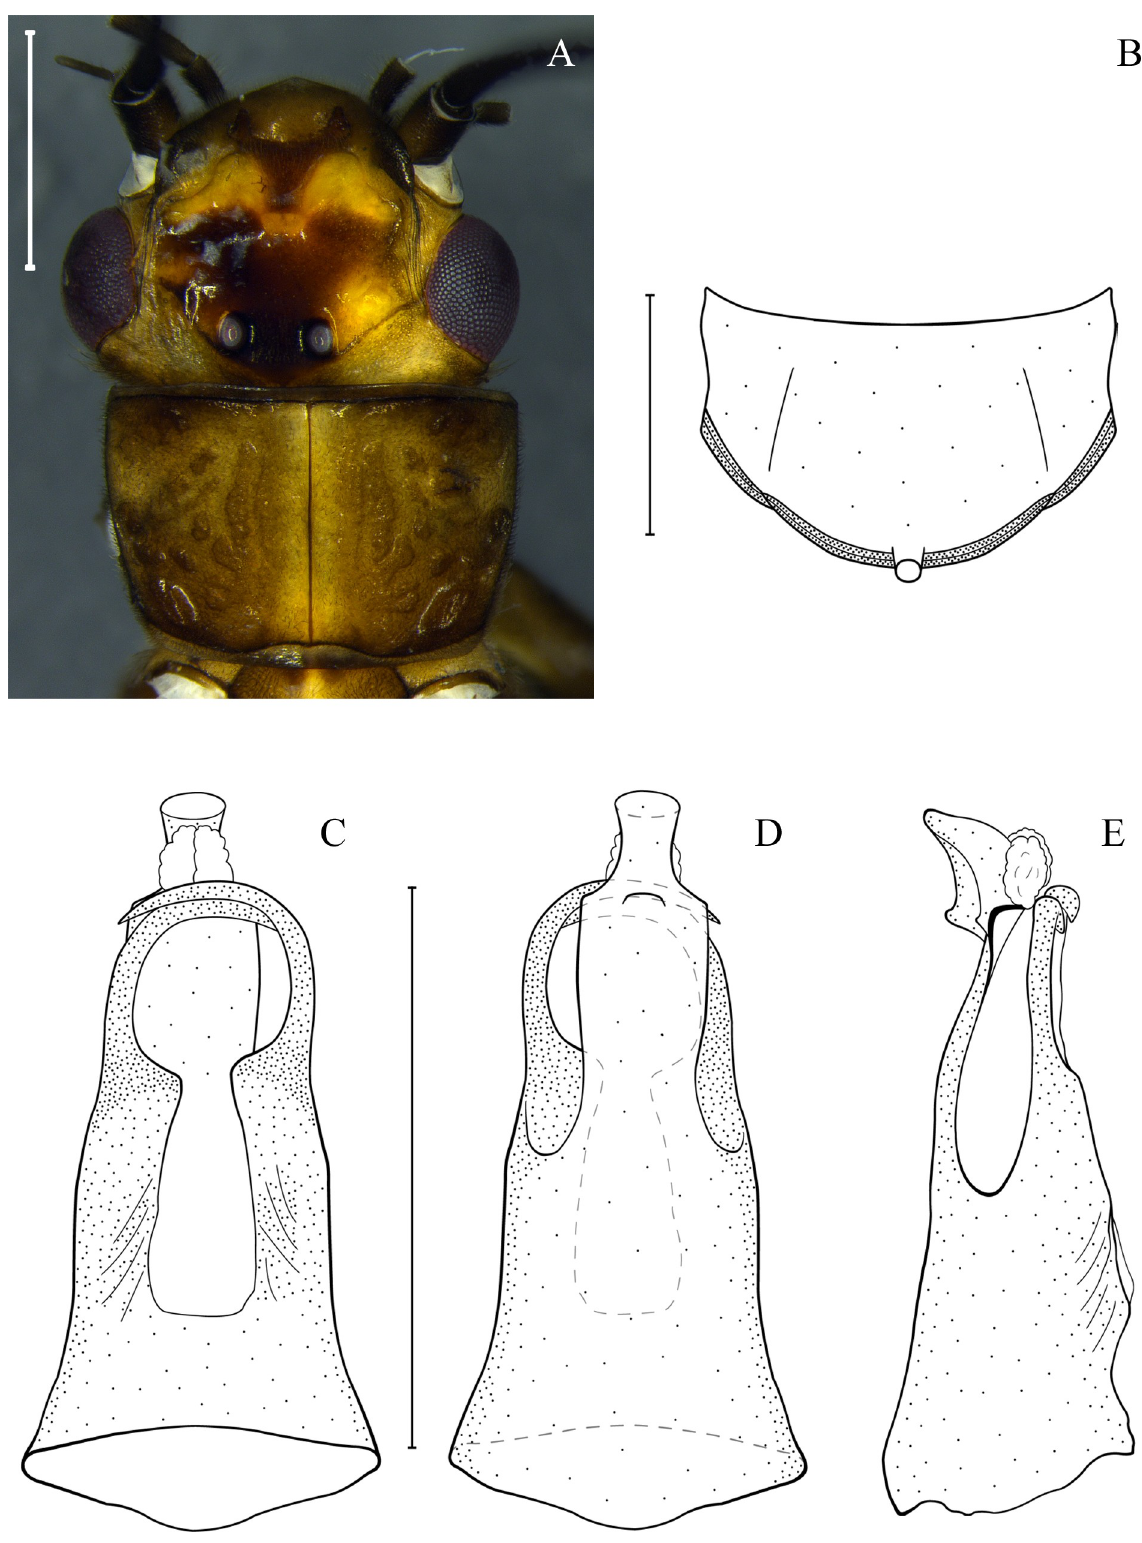
Fig 7. Anacroneuria debilis . Adult male, head and pronotum (A). Tergum 9 with hammer (B). Penial armature in ventral (C), dorsal (D), and lateral (E) views. Scale: 1 mm.